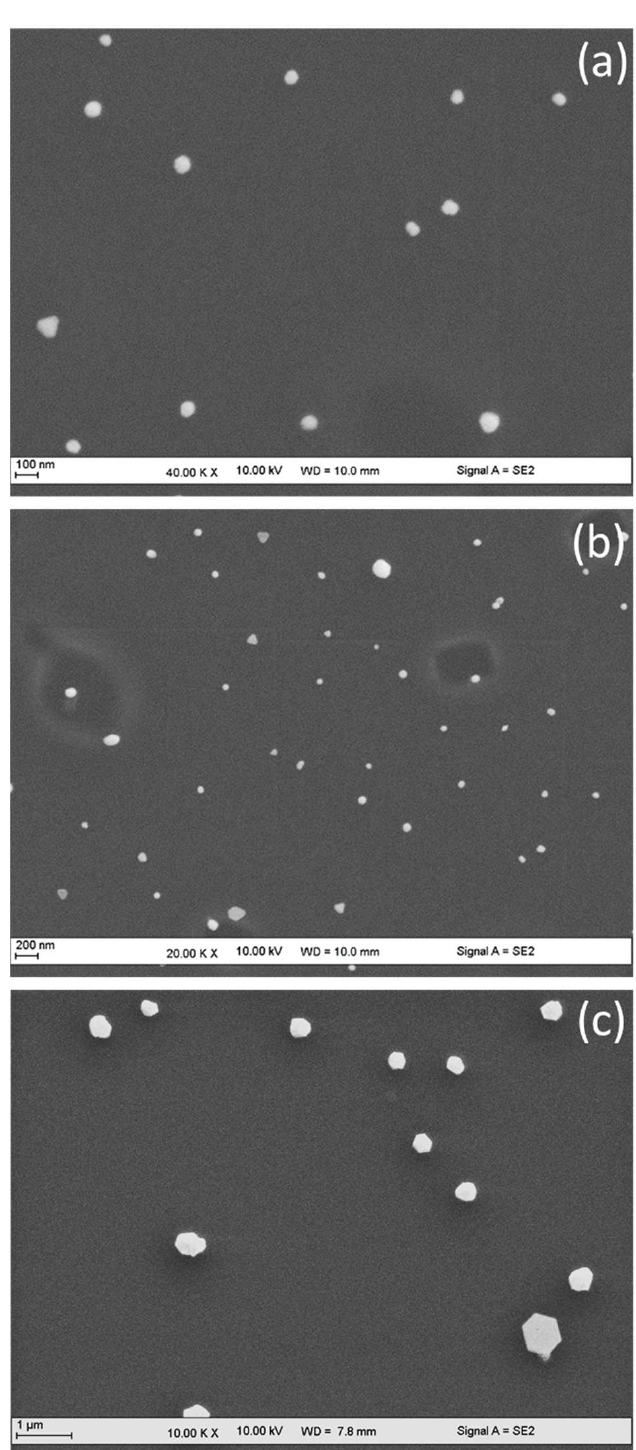
Figure 3. SEM images for gold nanoparticles obtained with HAuCl 4 ·2H 2 O (Hydrogen tetrachloroaurate) precursor and various solvent/non-solvent compositions. ( a ) Acetone/ethanol, ( b ) MIBK/ethanol, and ( c ) acetone/isopropanol.